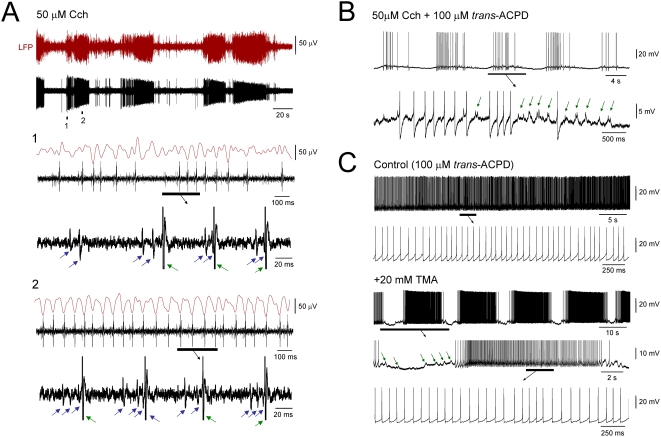
The ISO modulates network oscillations in the α (8–13 Hz) frequency band and can underlie cyclic paroxysms.A. Simultaneous LFP and multi-unit recording from the LGN in the presence of 50 µM Cch showing that the ISO in firing (bottom, MUA) is associated with a modulation of faster oscillations in the LFP (top). The sections labelled 1 and 2 are expanded below and reveal that the ∼13 Hz field oscillations are associated with HT bursts (blue arrows in expanded sections) that appear to drive activity in an additional tonic firing cell (red arrows in expanded sections) (see [27]). B. ISO at ∼0.1 Hz recorded intracellularly from an LGN TC neuron where the most depolarized phase of the oscillation is crowned not only by action potentials but also by a combination of spikelets and burstlets (green arrows in the enlarged section below). C. Top traces: LGN TC neuron recorded intracellularly showing continuous tonic firing (see enlarged section below). Bottom traces: application of 20 mM TMA brings about an ISO at ∼0.05 Hz. In this condition the cell also exhibits brief depolarizing events (green arrows) that occur just before and after the transient firing episodes (see enlargements as indicated).